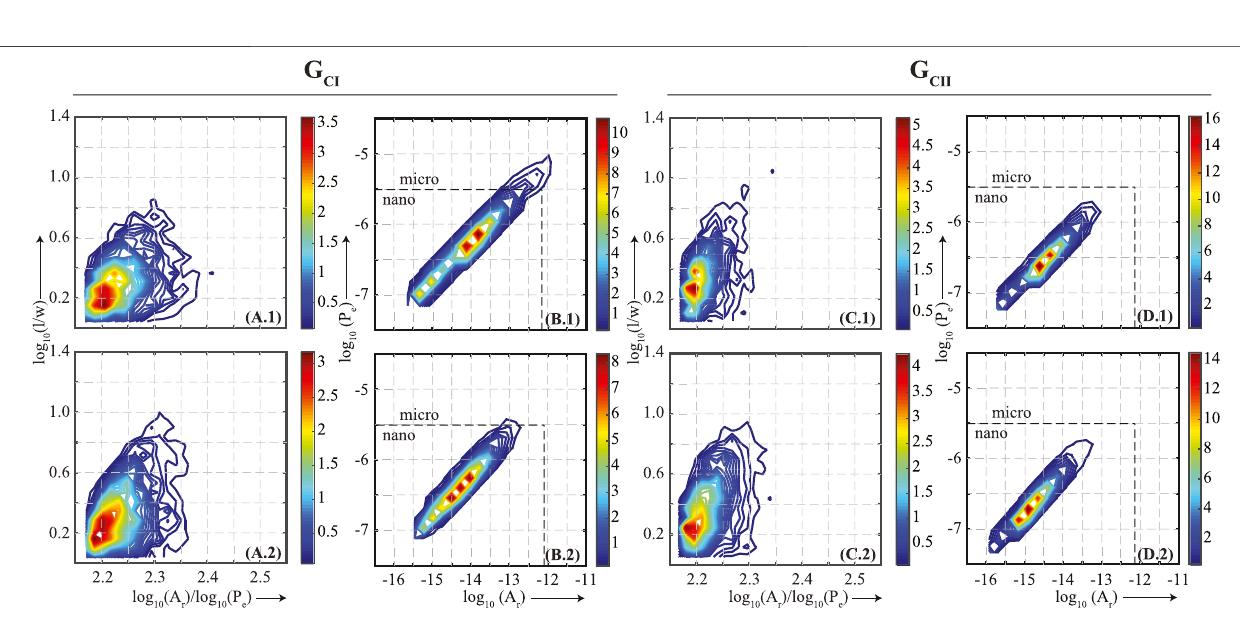
Frontiers in Earth Science |